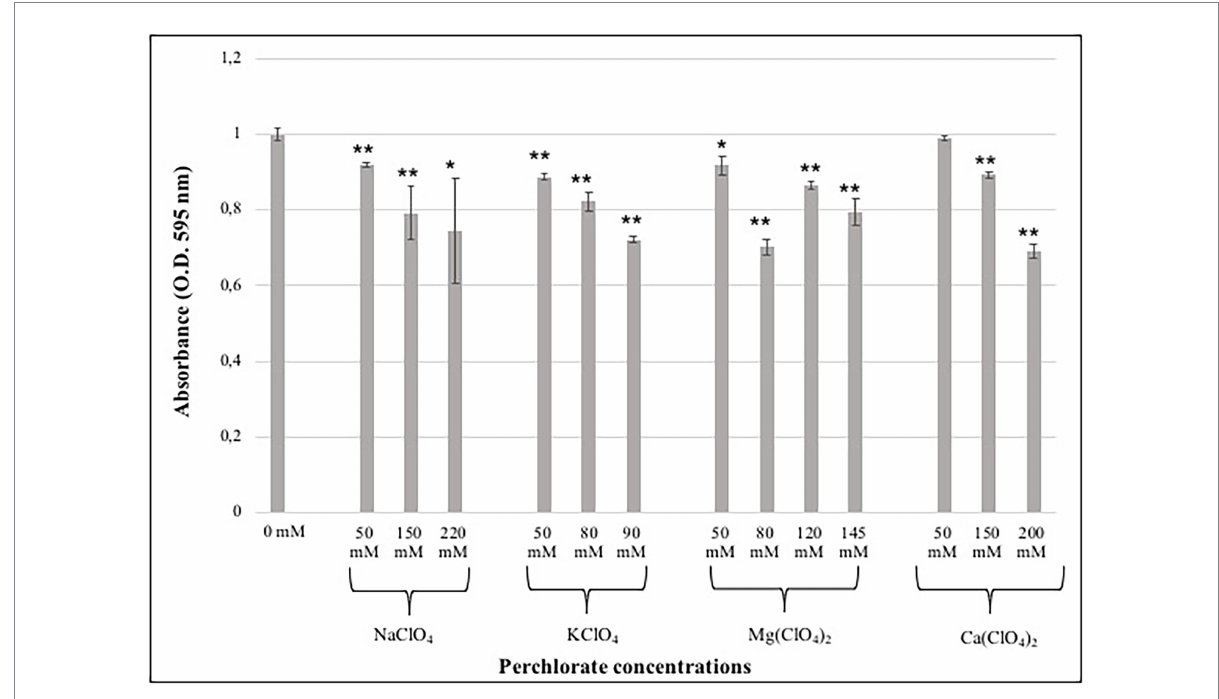
FIGURE 2 Effect of different perchlorate concentrations on the metabolic activity of C. antarcticus colonies. Showed results are after 72 h of incubation with the DMSO. Concentrations are expressed in mM. Data were normalized against the control (0 mM). Significant differences were calculated by t test with * = p < 0.05 and ** = p <